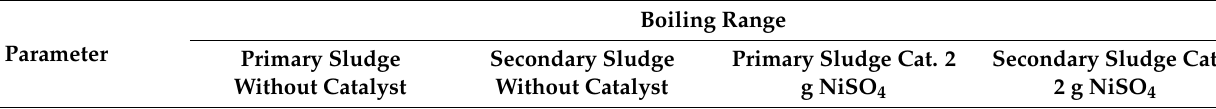
Table 6. Results of element